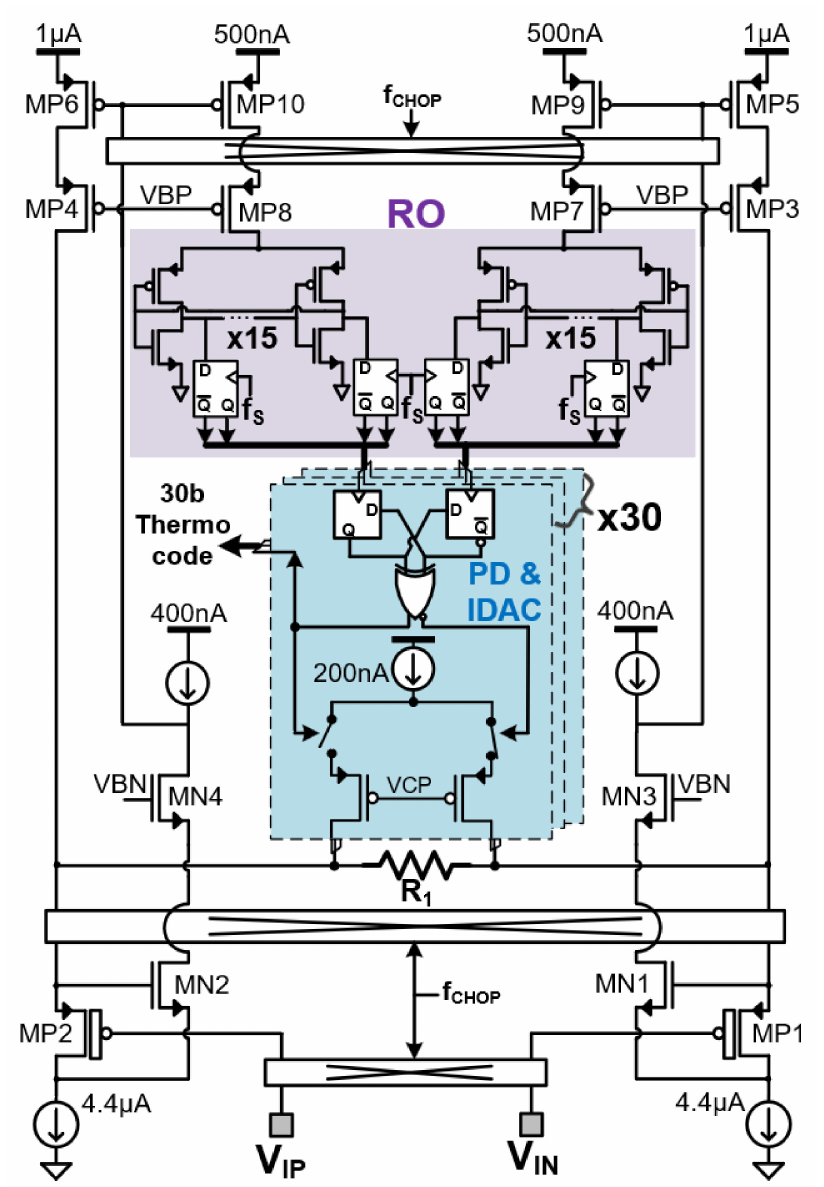
Figure 2. Transistor-level schematic of the proposed VCO-based